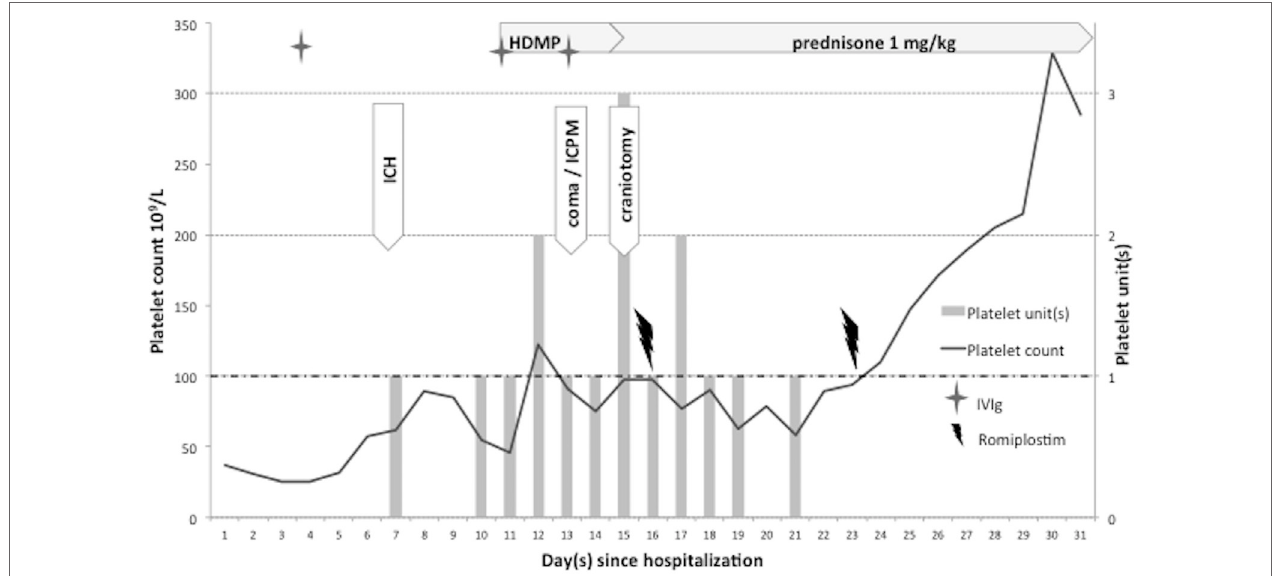
FIgURe 1 | Patient 1. Platelet counts and platelet transfusions during intensive care hospitalization. Combined therapy including romiplostim as emergency management for severe immune thrombocytopenia complicated by intracranial hemorrhage (ICH). Intracranial pressure monitoring (ICPM); Romiplostim dose: 1 μ g/kg subcutaneously; intravenous immunoglobulin (IVIg) dose: 1 g/kg; and high-dose methyl prednisolone (HDMP): 15